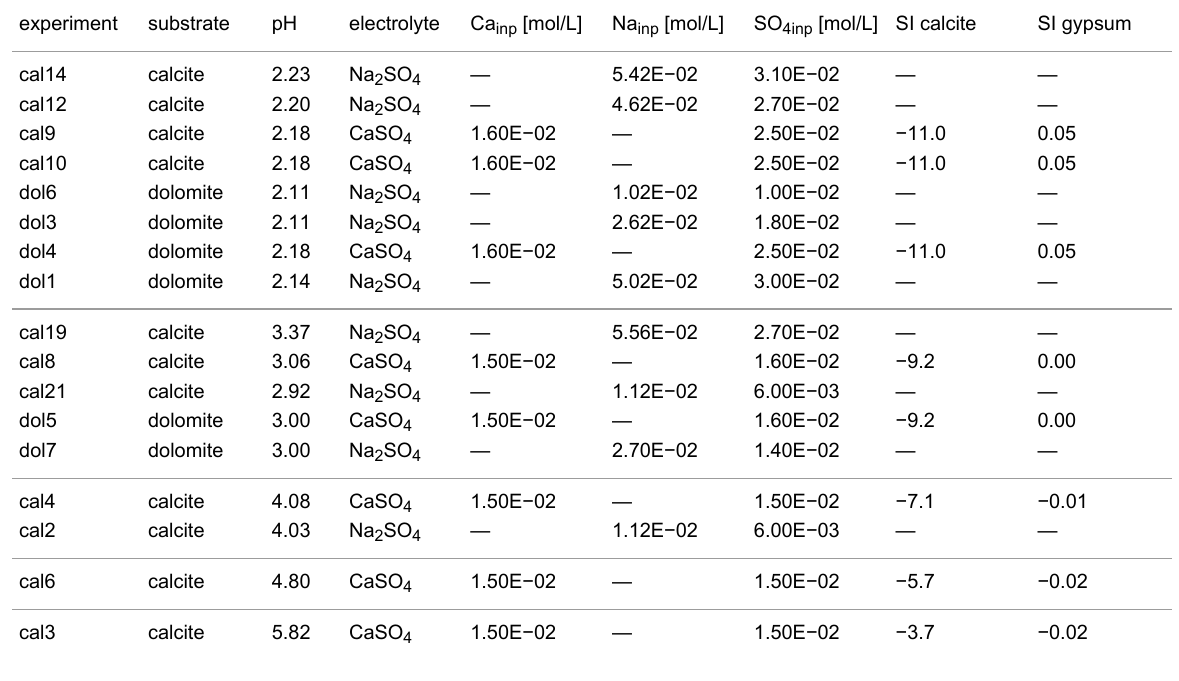
Table 1: Experimental